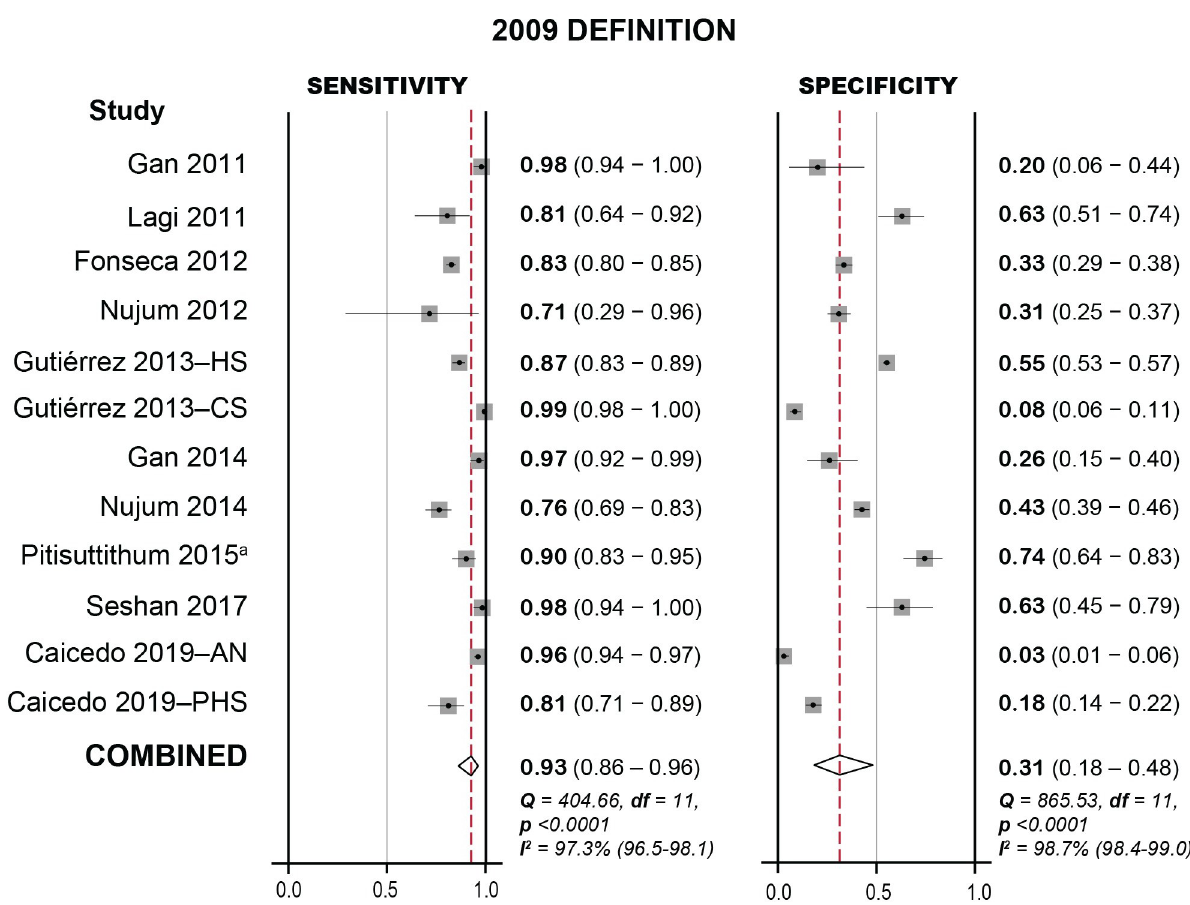
Fig 4. Forest plot for sensitivity and specificity of the WHO 2009 case definition for probable dengue. Meta-analysis carried out in Stata/IC 14 using the MIDAS statistical package. 95% confidence intervals given in parentheses. HS: hospital study; CS: cohort study; AN: Aedes Network Study; PHS: Public Health Surveillance Network Study. a: Calculated sensitivity differs from the reported value (0.909).